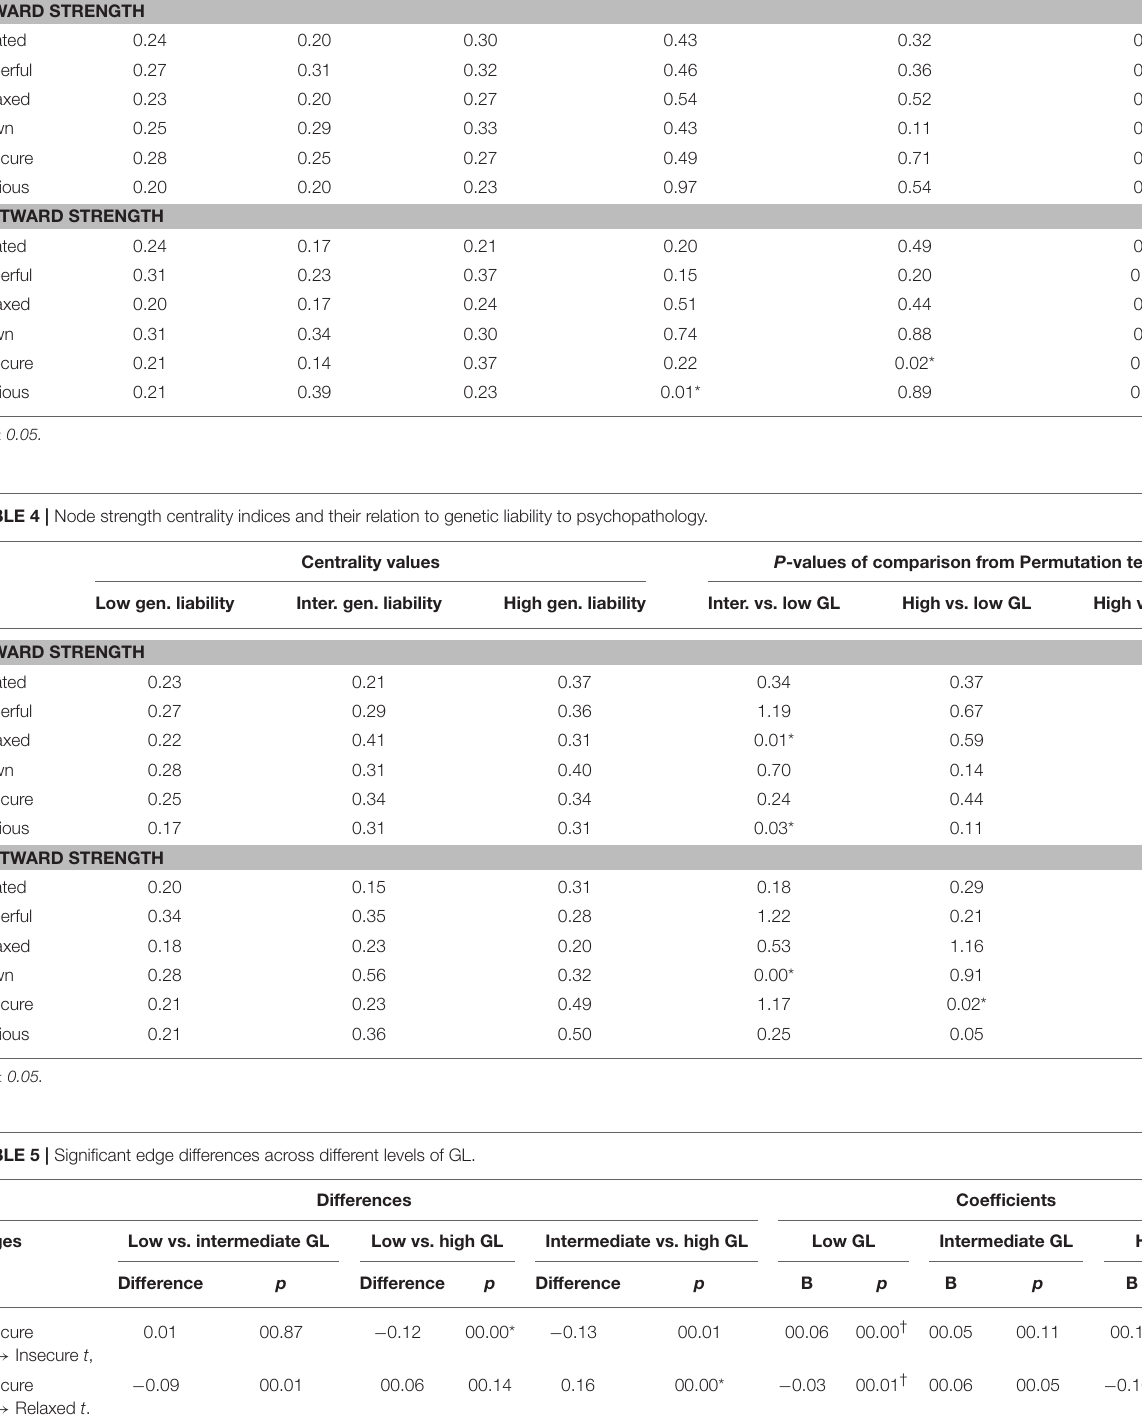
TABLE 3 | Node strength centrality across levels of childhood trauma. Centrality values P -values of comparison from Permutation tests Low CT Medium CT High CT Medium vs. Low CT High vs. Low CT High vs. Medium CT